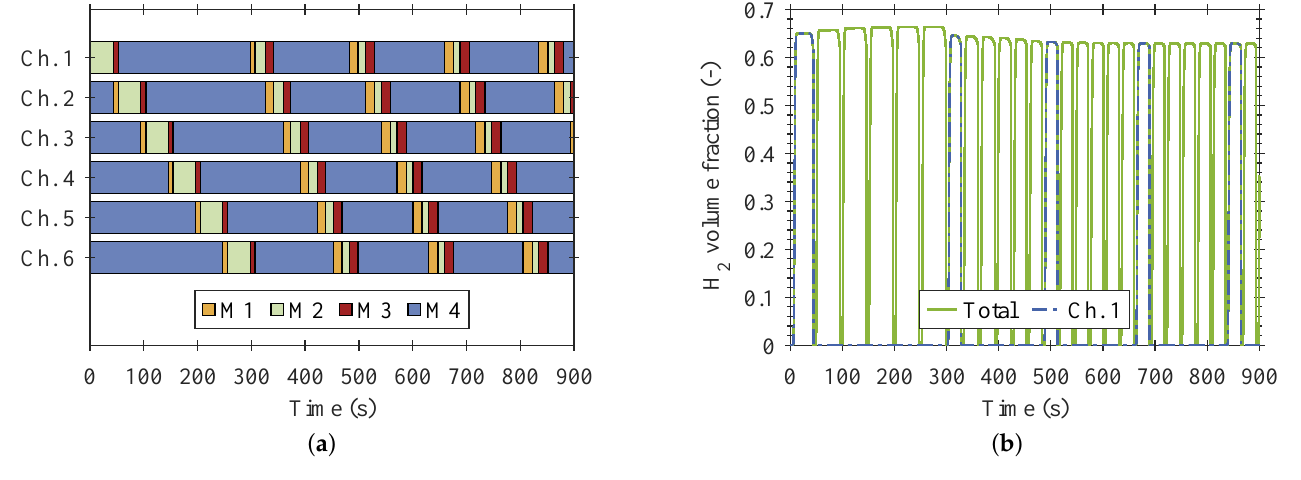
Figure 9. ( a ) Operation scheme for six reaction chambers, and ( b ) H 2 volume fraction in the product for all chambers combined ("total") and for chamber 1 for the first 900s. Switching condition M2 to M3: CO 2 volume fraction in product > 0.05; M3 to M4: CO 2 volume fraction to subsequent chamber >